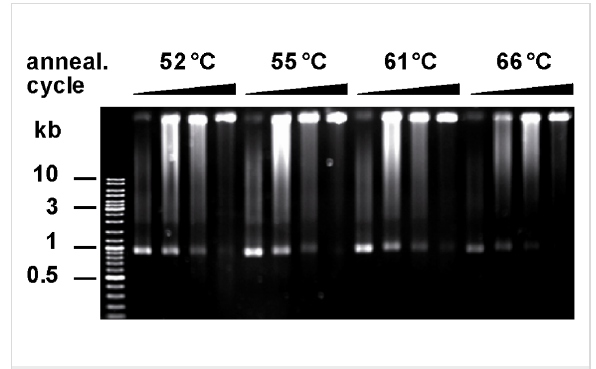
Figure 3: Generation of DNA networks with Taq DNA polymerase from 1062 nt template using primer ODN I and ODN II . Monitoring of DNA network growth influenced by varying of annealing temperature (as indicated) and increasing cycles (10, 18, 22, 28, respectively).